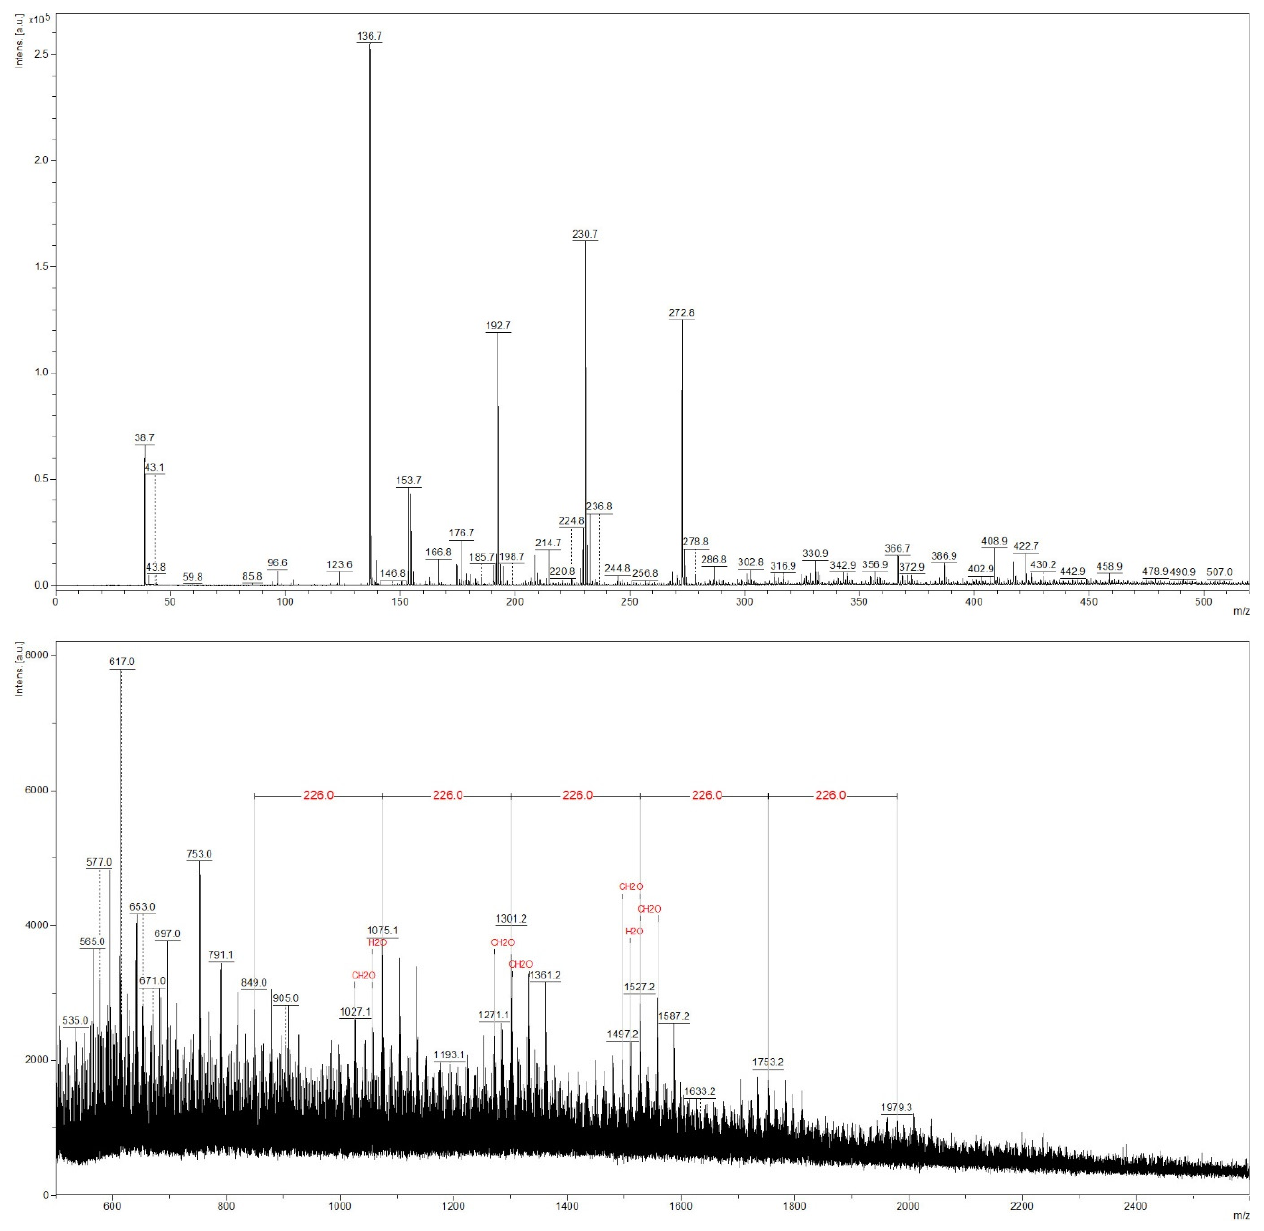
Figure 4. The MALDI-TOF mass spectrum of the beech red heartwood extract.